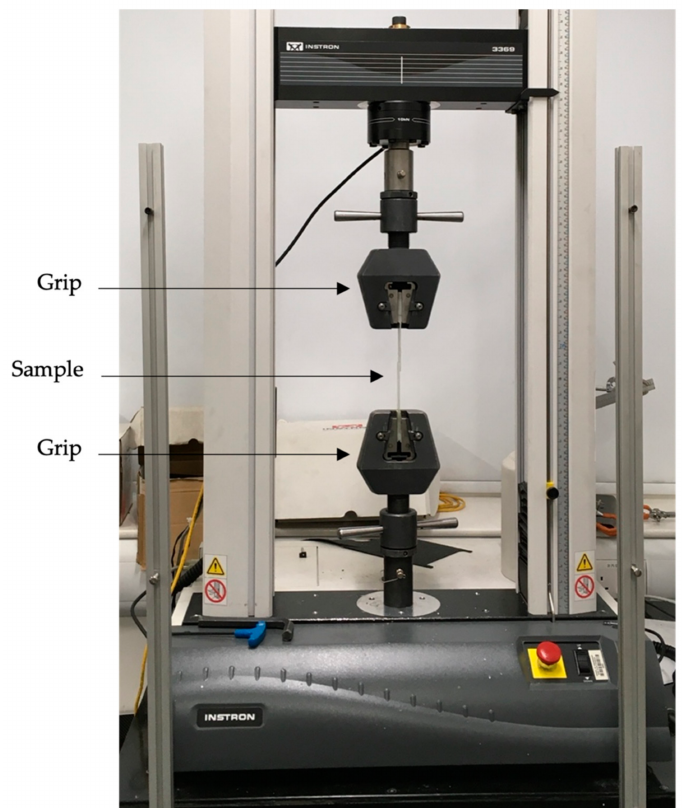
Figure 7. Lap shear strength test setup on an INSTRON 10 kN universal testing system.